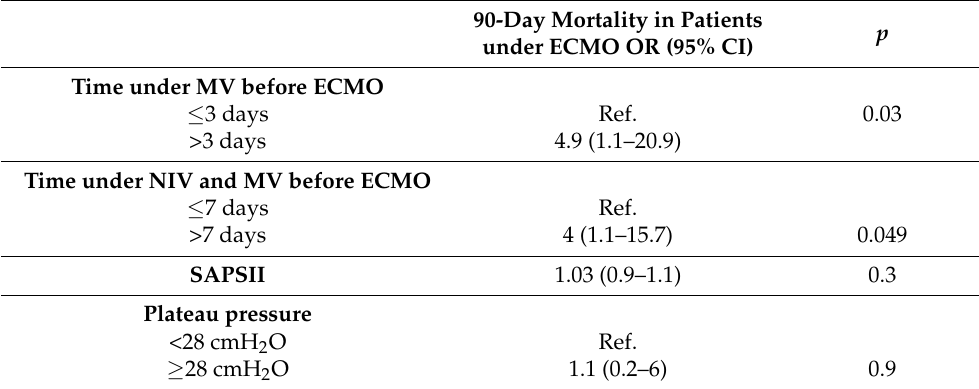
Table 2. Association between days under mechanical ventilation and total days of ventilation before ECMO and 90-day